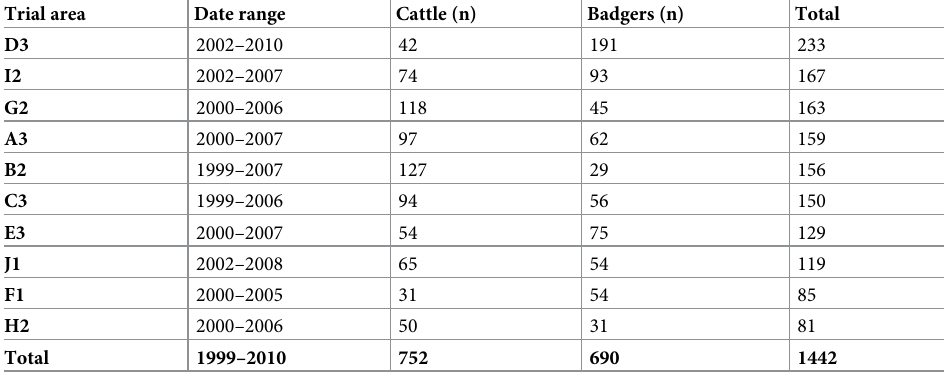
Table 1. Breakdown of the 1,442 sequenced M . bovis isolates by triplet and host. The table is ordered by total num- ber of isolates from high to low. Trial